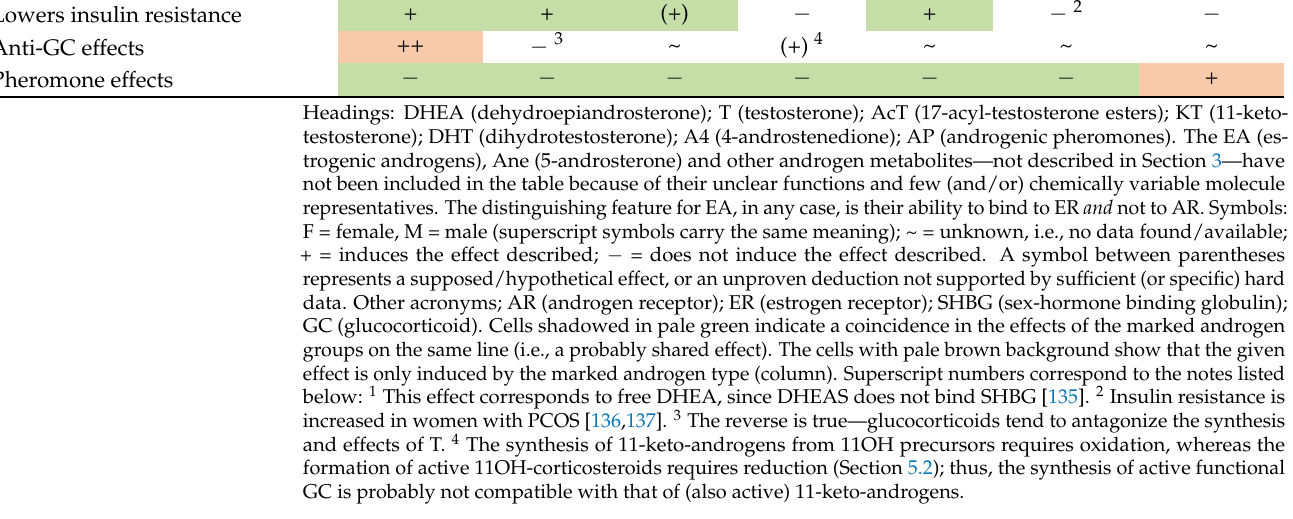
Headings: DHEA (dehydroepiandrosterone); T (testosterone); AcT (17-acyl-testosterone esters); KT (11-keto- testosterone); DHT (dihydrotestosterone); A4 (4-androstenedione); AP (androgenic pheromones). The EA (es- trogenic androgens), Ane (5-androsterone) and other androgen metabolites—not described in Section 3—have not been included in the table because of their unclear functions and few (and/or) chemically variable